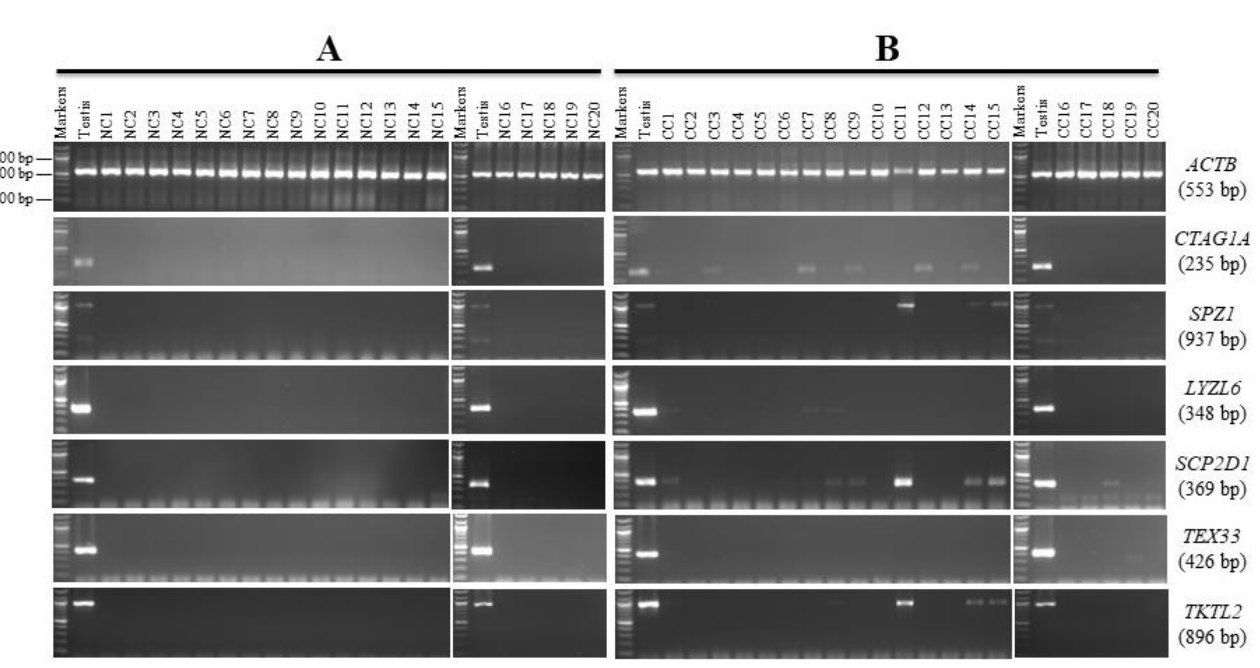
Figure 3. RT-PCR expression profiles for the candidate colon cancer markers in matching normal colon (NC) and colon cancer (CC) tissues. Agarose gels display the RT-PCR analysis for the CTAG1A, SPZ1, LYZL6, SCP2D1, TEX33, and TKTL2 genes. cDNAs were synthesized from the total RNA from 20 NC tissues ( A ) and CC tissues ( B ). ACTB expression was used as a positive control for the cDNA samples. Testis cDNA was used to test the primer for each gene. The expected product size of each gene is presented on the right between brackets.